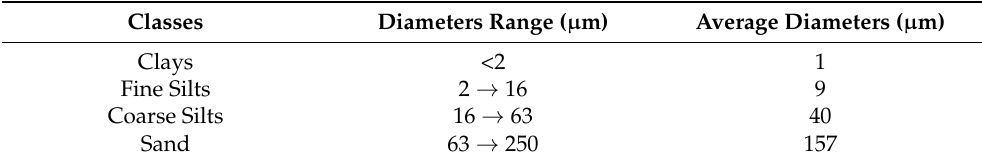
Table 1. Classification of the mineral suspended sediments. Classes Diameters Range ( µ m) Average Diameters ( µ m)